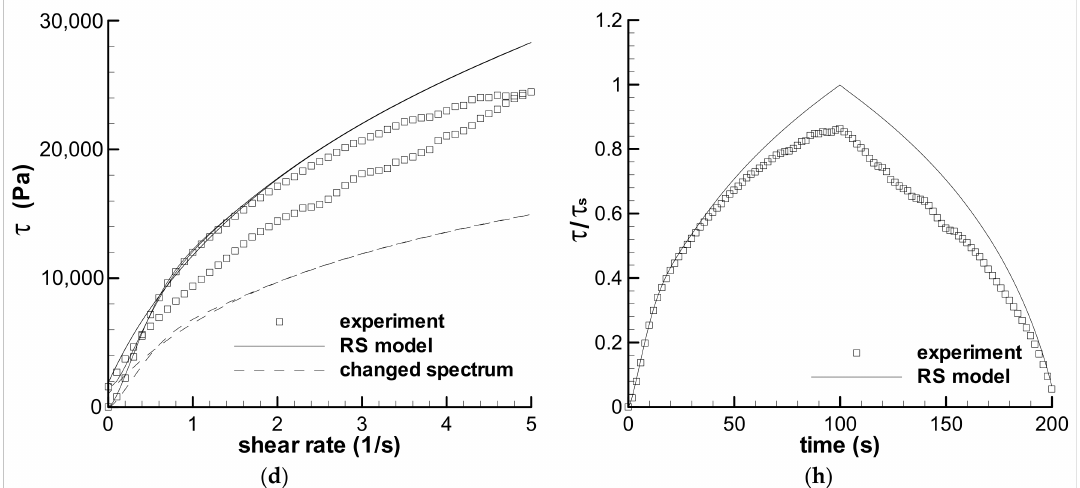
Figure 8. Predictions of the triangular-loop experiments with the same characteristic time t 0 of 100 s. The stress–shear rate curves with maximum shear rates of 0.1 s − 1 ( a ), 1 s − 1 ( b ), 3 s − 1 ( c ), and 5 s − 1 ( d ) are given. The stress–time curves with the maximum shear rates of 0.1 s − 1 ( e ), 1 s − 1 ( f ), 3 s − 1 ( g ), and 5 s − 1 ( h ) are also shown. Symbols are experiments, solid lines are the calculations by the RS model, bold dashed lines in ( a , e ) are the calculations by the modified spectrum with f in Table 4, dashed line in ( d ) is calculated using a changed spectrum in Table 5, and τ s is the steady shear stress calculated by the RS model at the maximum shear rate.